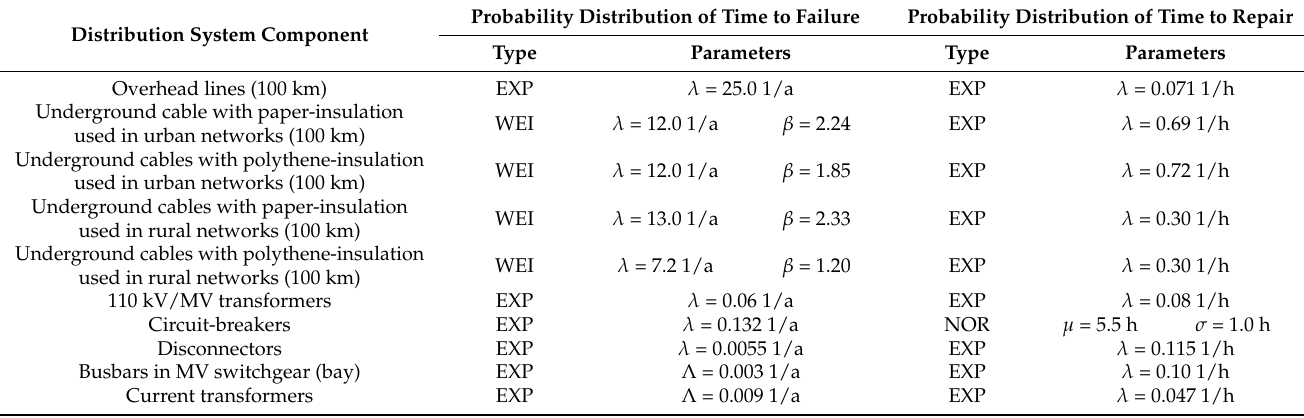
Table 1. Reliability parameters of selected types of MV distribution system elements; elaborated on the basis of